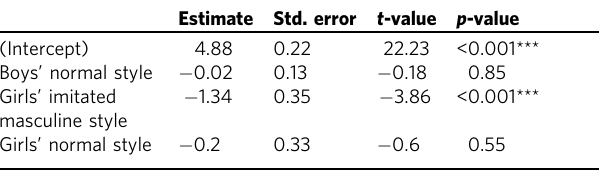
Table 16 Results of the linear-mixed-effects regression model for sentiment